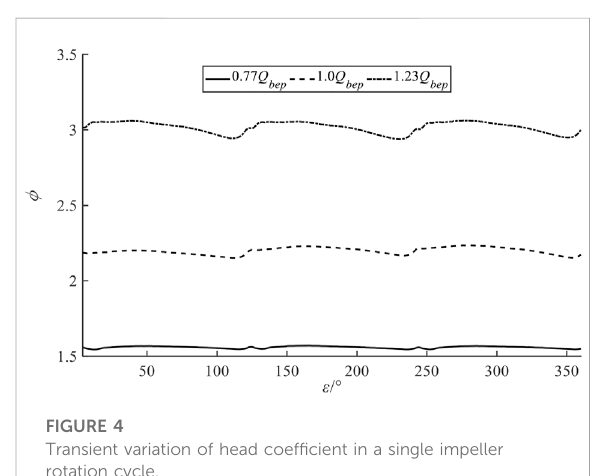
Transient variation of head coef fi cient in a single impeller rotation